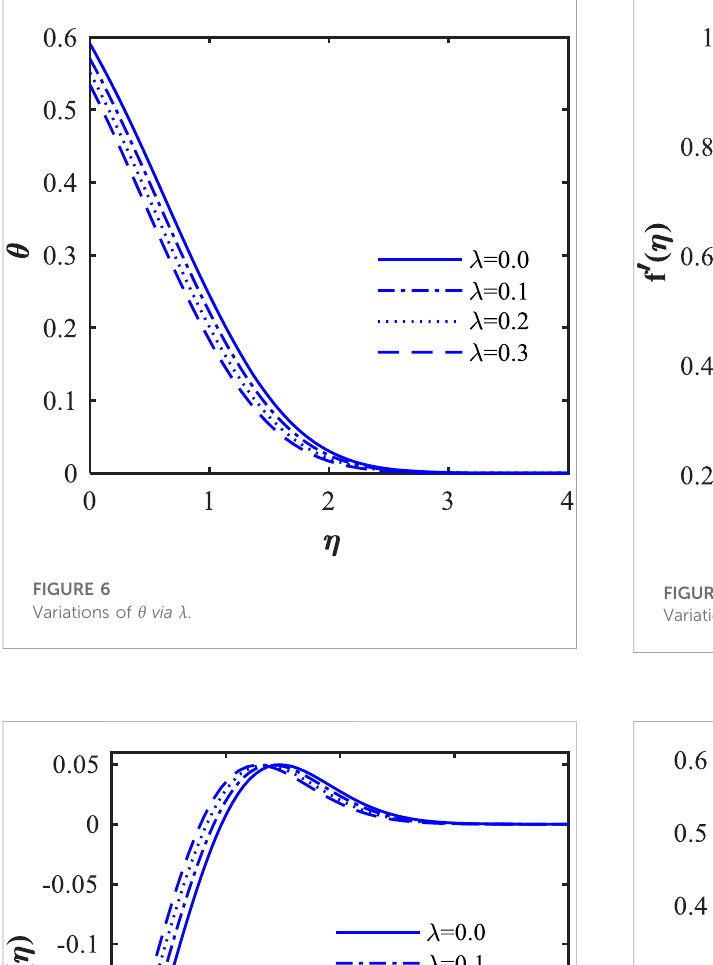
FIGURE 8 Variations of f ′ via β .